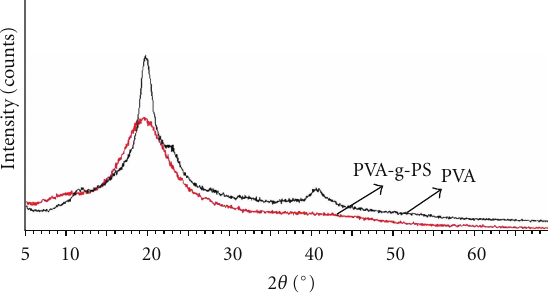
Figure 10: XRD spectra of PVA and PVA-g